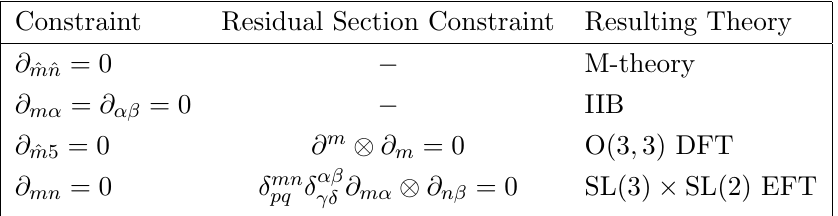
Table 1 . The possible solutions and partial solutions that can be obtained from the SL(5) section